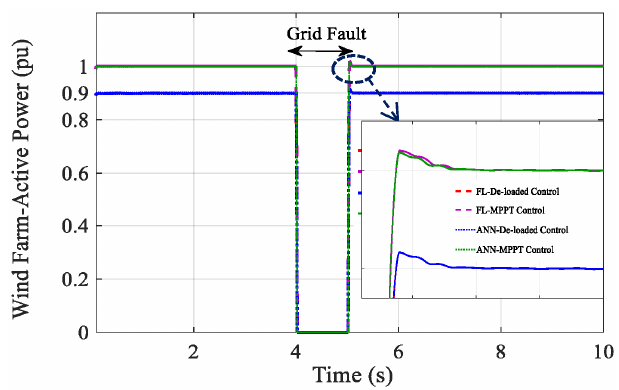
Figure 12. The voltage at PCC at the time of the grid-voltage sag. Figure 13. Grid active power at the time of the grid-voltage Figure 13. Grid active power at the time of the grid-voltage sag.